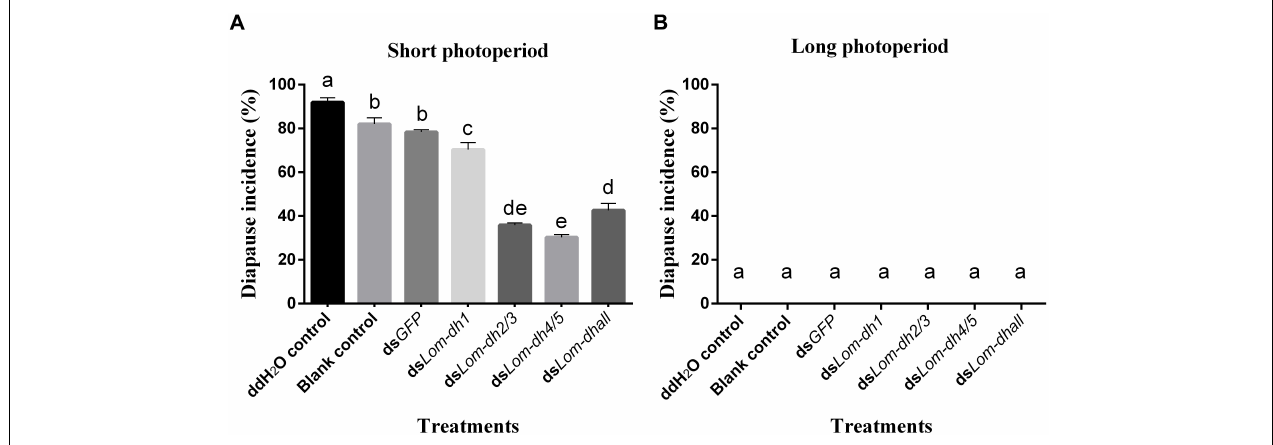
FIGURE 6 | (A) Diapause incidence after injecting ds Lom-dh to RNAi Lom-dh genes of L. migratoria under short photoperiod. (B) Diapause incidence after injecting ds Lom-dh to RNAi Lom-dh genes of L. migratoria under long photoperiod. The lowercase a, b, c, d, and e indicated that statistically significant difference of diapause incidence was considered on an error probability of p < 0.05 by one-way ANOVA using Duncan’s multiple-range